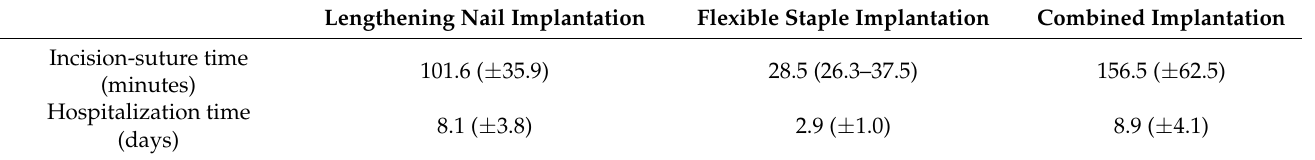
Table 3. Perioperative